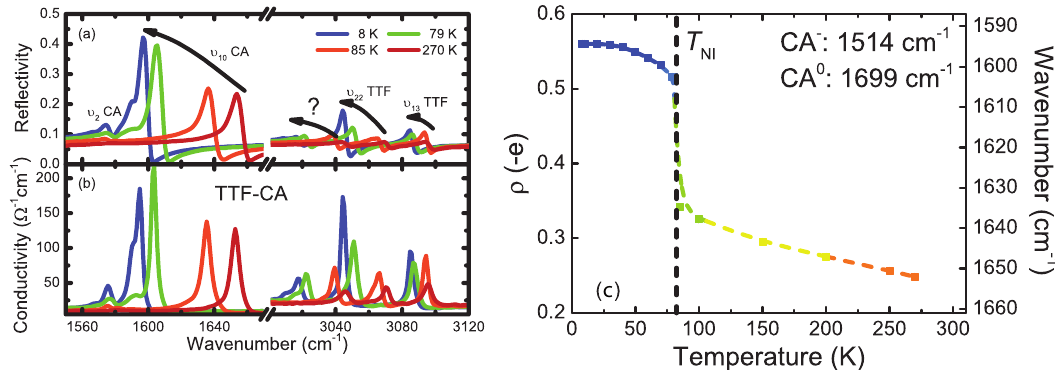
Figure 14. ( a ) Reflectivity and ( b ) optical conductivity of TTF-CA for four different temperatures between 1550 cm − 1 and 1670 cm − 1 . The first mode is ascribed to the charge sensitive, ungerade b 1u ν 10 mode of CA. The neighboring satellite peak belongs to the symmetric ν 2 -mode of CA; ( c ) Temperature-dependent evolution of the resonance frequency of the ν 10 -mode. From Equation (4) and the calculated values in Table C1, the ionicity of CA can be determined. At the phase transition, the molecular charge jumps from 0.34 e to 0.51 e and increases